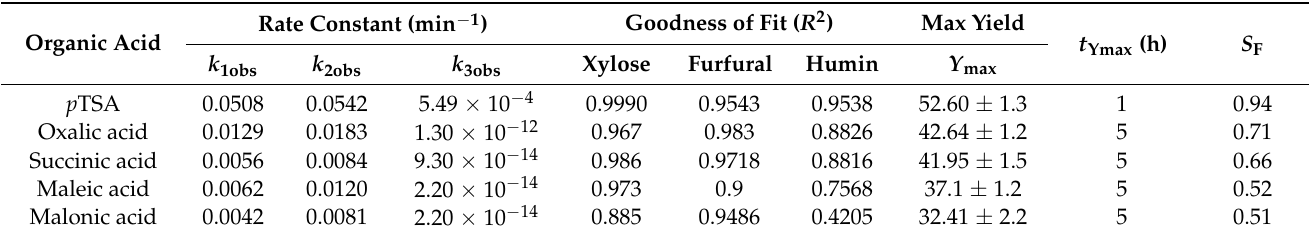
Figure 4. Kinetic plots of dehydration of xylose into furfural. Reaction conditions: 0.5 M xylose, 1.0 M organic acid, and 0.1 M CrCl 3 · 6H 2 O catalysts in 50 mL DMSO at 120 ◦ C for 5 h; ( A ) p TSA; ( B ) Oxalic acid; ( C ) Succinic acid; ( D ) Malonic acid; ( E ) Maleic acid. Lines represent calculated data whereas symbols represent experimental values. X: xylose; FF: furfural; HUM; humin. Table 4. Fitted reaction parameters for xylose conversion into furfural in DMSO. Reaction conditions: 0.5 M xylose, 1.0 M